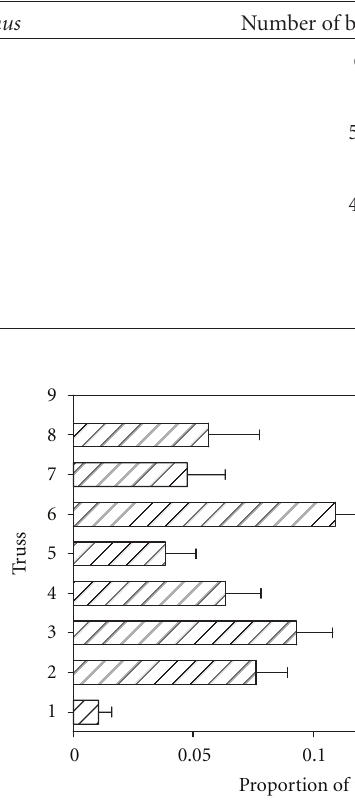
Figure 4: Distribution of blemishing on tomato fruits at di ff erent heights (truss 1: low and most mature, truss 8: high and most immature) on tomato plants 14d after release of Dicyphus hesperus’ adults and